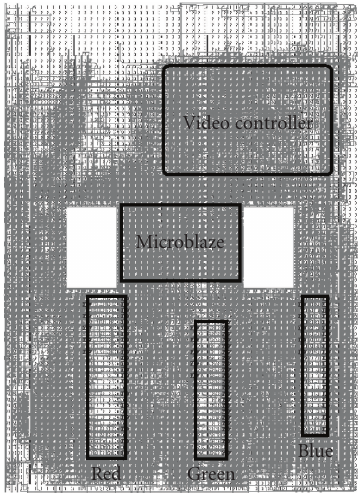
Figure 8: Floorplan of video processing implementation in an Xilinx